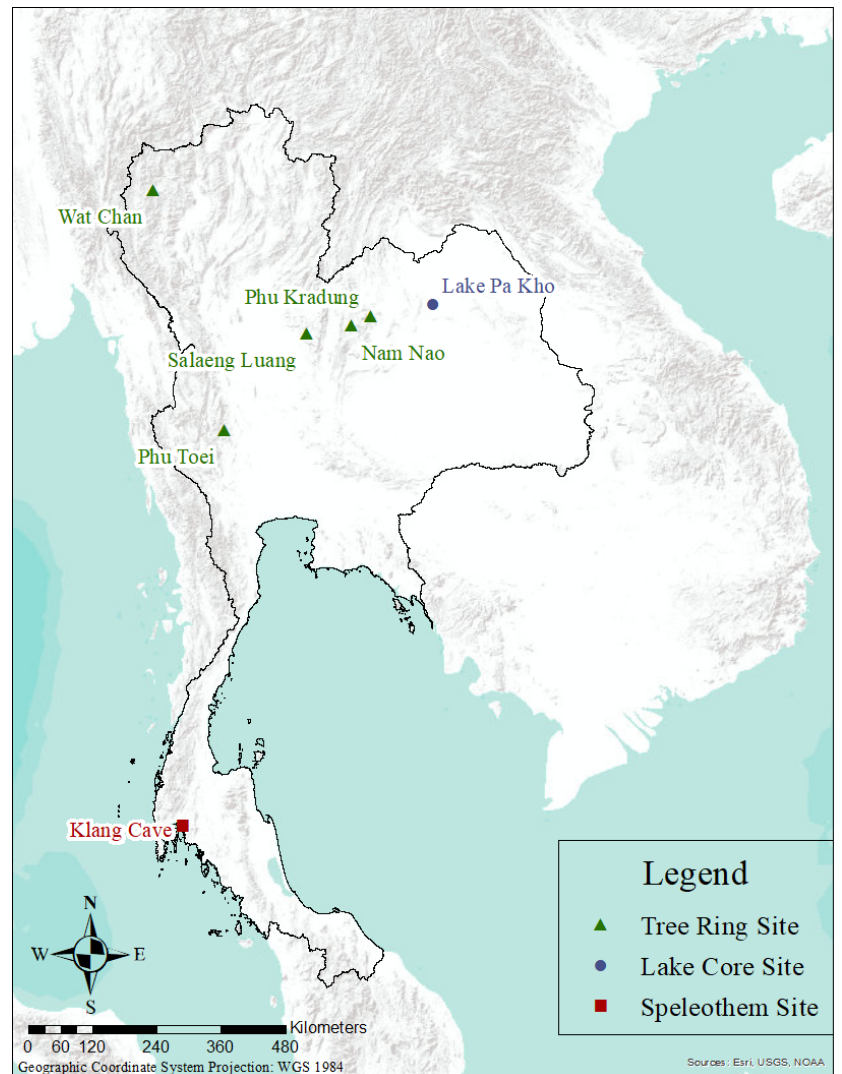
Figure 2. Location of proxy records in